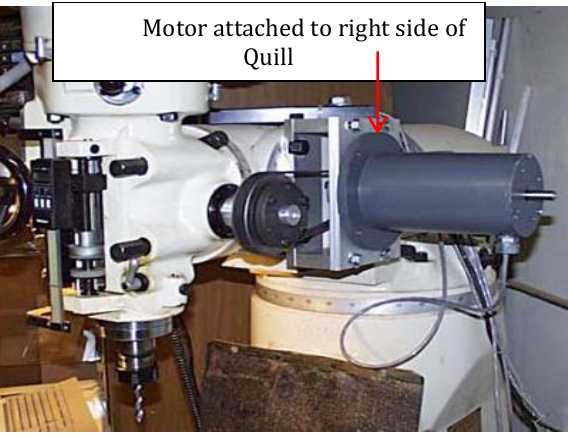
Figure 2: Rotary Actuator to Quill based Z-axis Movement, right side attachment Motor attached to right side of